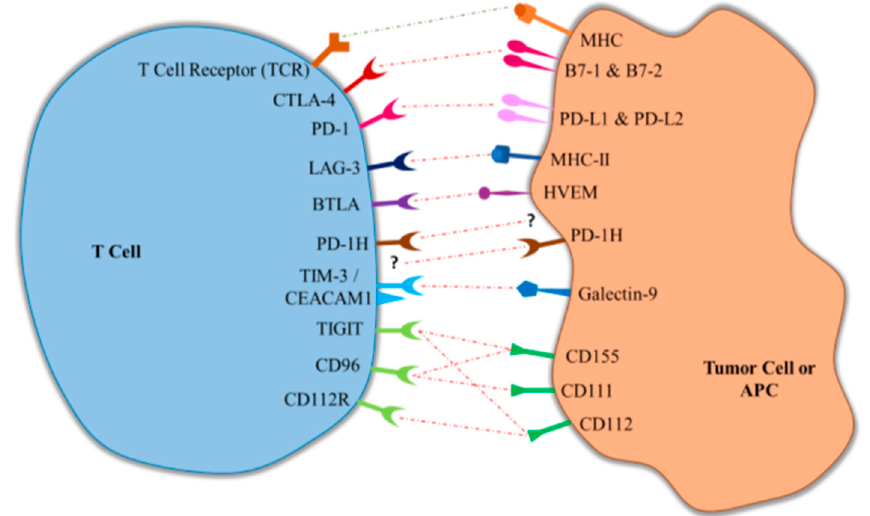
Figure 1. Interaction of immune checkpoint receptors and their respective ligands. LAG-3, lymphocyte activation gene-3; BTLA, B and T lymphocyte attenuator; PD-1H, programmed death-1 homolog; CTLA-4, cytotoxic T-lymphocyte-associated antigen 4; TIM-3, T-cell immunoglobulin- and mucin-domain-containing molecule; TIGIT, T cell immunoglobulin and immunoreceptor tyrosine- based inhibitory motif domain; PD-1, programmed death protein-1; CEACAM1, carcinoembryonic antigen cell adhesion molecule 1; MHC-II, class II major histocompatibility complex; FDA, United States Food and Drug Administration; APCs, antigen-presenting cells; HVEM, herpesvirus entry mediator.